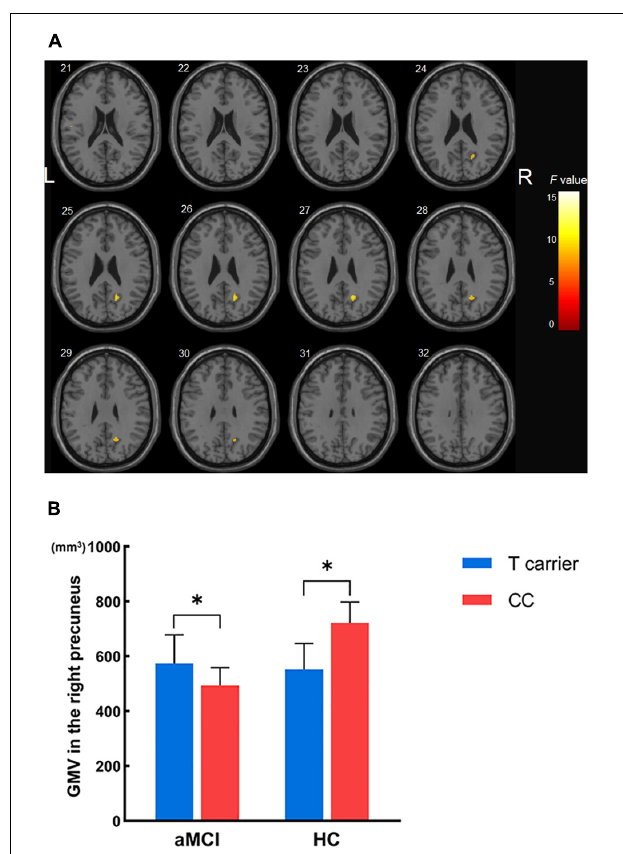
FIGURE 3 | The interaction effects of diagnosis × MTHFR C677T genotype on gray matter volume in all subjects not carrying the APOE ε 4 allele. (A) Significant interactions were found in the right precuneus. (B) Gray matter volume of the right precuneus across the four groups. ∗ p < 0.05; GMV, gray matter